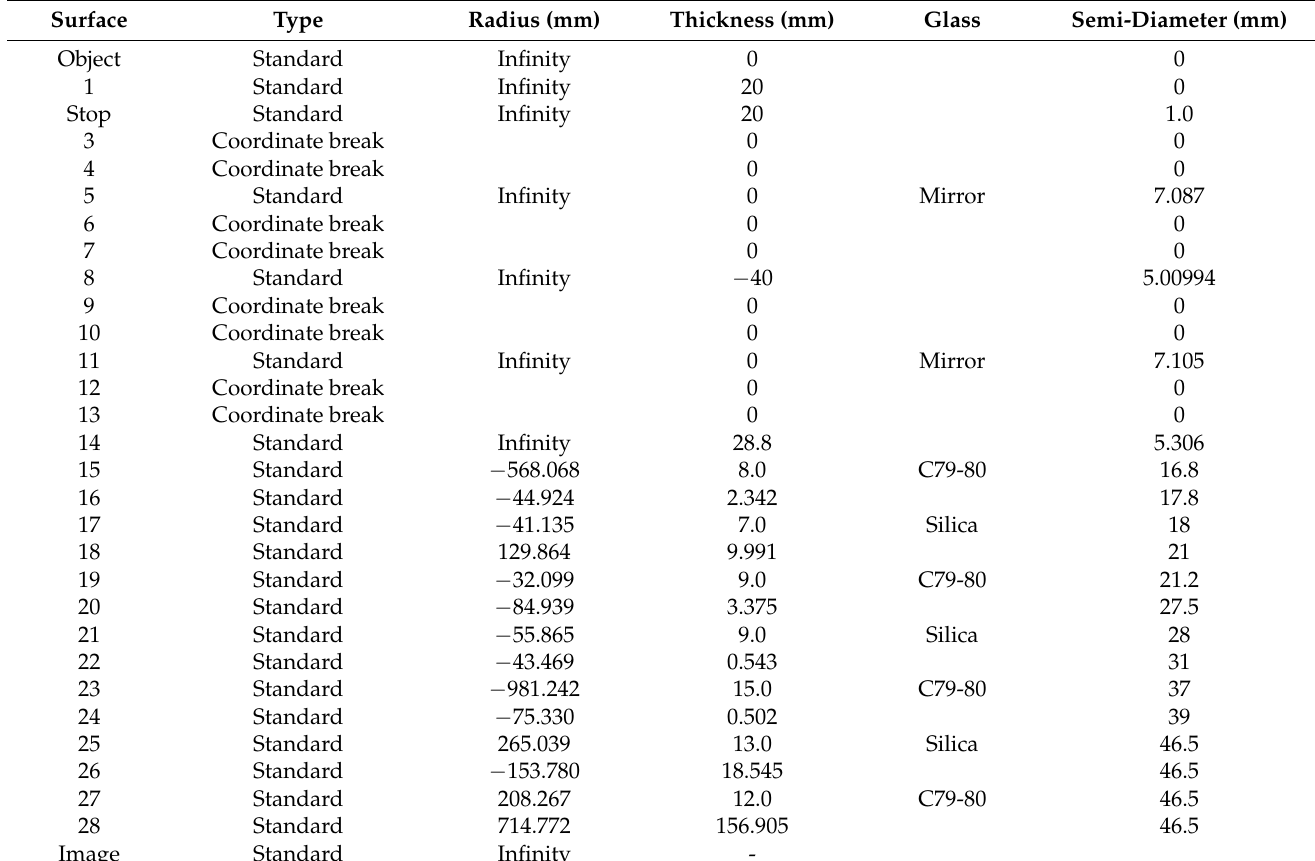
Table 1. The design parameters of a 1D scanning system using two galvanometers.